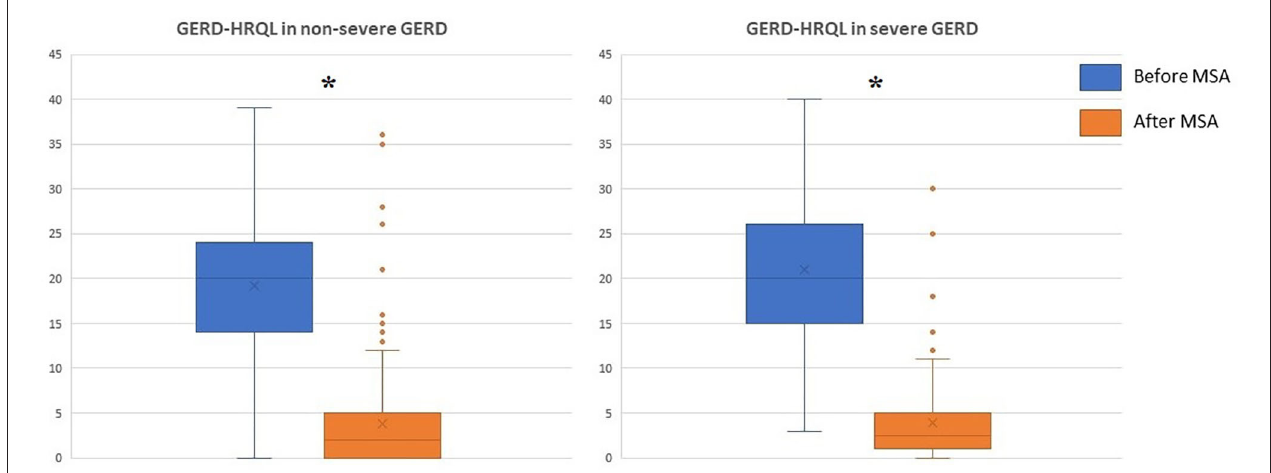
FIGURE 2 | GERD-HRQL scores before and after laparoscopic MSA in patients with or without severe GERD. GERD-HRQL, gastroesophageal reflux disease health-related quality of life; MSA, magnetic sphincter augmentation; GERD, gastro-esophageal reflux disease; * p < 0.05.